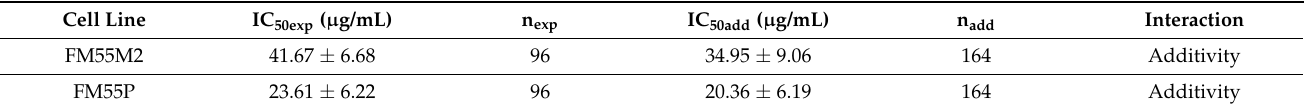
Table 4. Type I isobolographic analysis of interactions for non-parallel concentration–response re- lationship lines between amantadine and MTO at the fixed drug concentration ratio of 1:1 in A375 cell line. Results are median inhibitory concentrations (IC 50 values in µg/mL ± S.E.M.) for two-drug Table 3. Type I isobolographic analysis of interactions for parallel concentration–response relationship mixtures, determined either experimentally (IC 50exp ) or theoretically calculated (IC 50add ) from the lines between amantadine and CDDP at the fixed drug concentration ratio of 1:1 in two melanoma equations of additivity, blocking proliferation in 50% of tested cells in melanoma cell line A375 cell lines FM55P and FM55M2. Results are median inhibitory concentrations (IC 50 values in µ g/mL measured in vitro by the MTT assay. L-IC 50 —lower additive IC 50 value, U-IC 50 —upper additive IC 50 value. ± S.E.M.) for two-drug mixtures, determined either experimentally (IC 50exp ) or theoretically calcu- lated (IC 50add ) from the equations of additivity, blocking proliferation in 50% of tested cells in two melanoma cell lines (FM55M2 and FM55P) measured in vitro by the MTT assay.